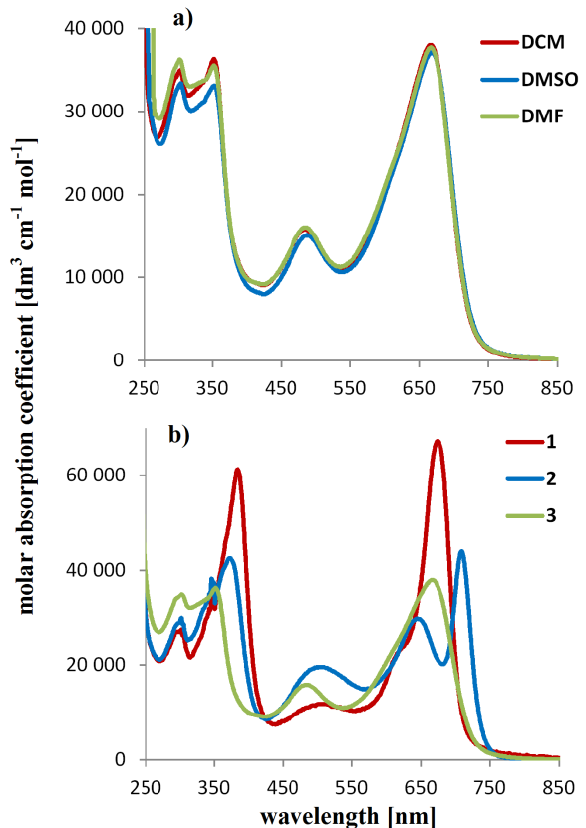
Figure 1. UV – VIS spectra of ( a ) Pz3 in dichloromethane (DCM), dimethylsulfoxide (DMSO),